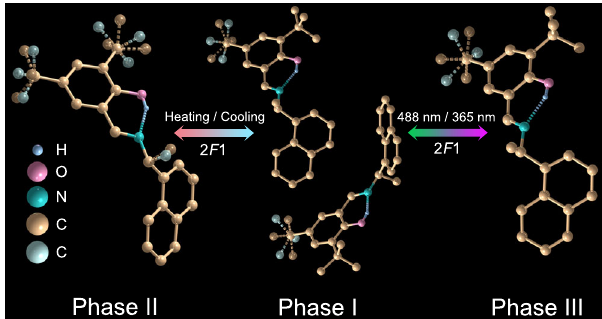
Fig. 2 Crystal structures. Asymmetric units of SA-NPh-( R ) in Phase I, II, and III. The dotted lines between N and H atoms indicate O-H … N hydrogen bonding. Some H atoms were omitted for clarity. The disordered tert -butyl and methyl substituents are distinguished by tan and light turquoise